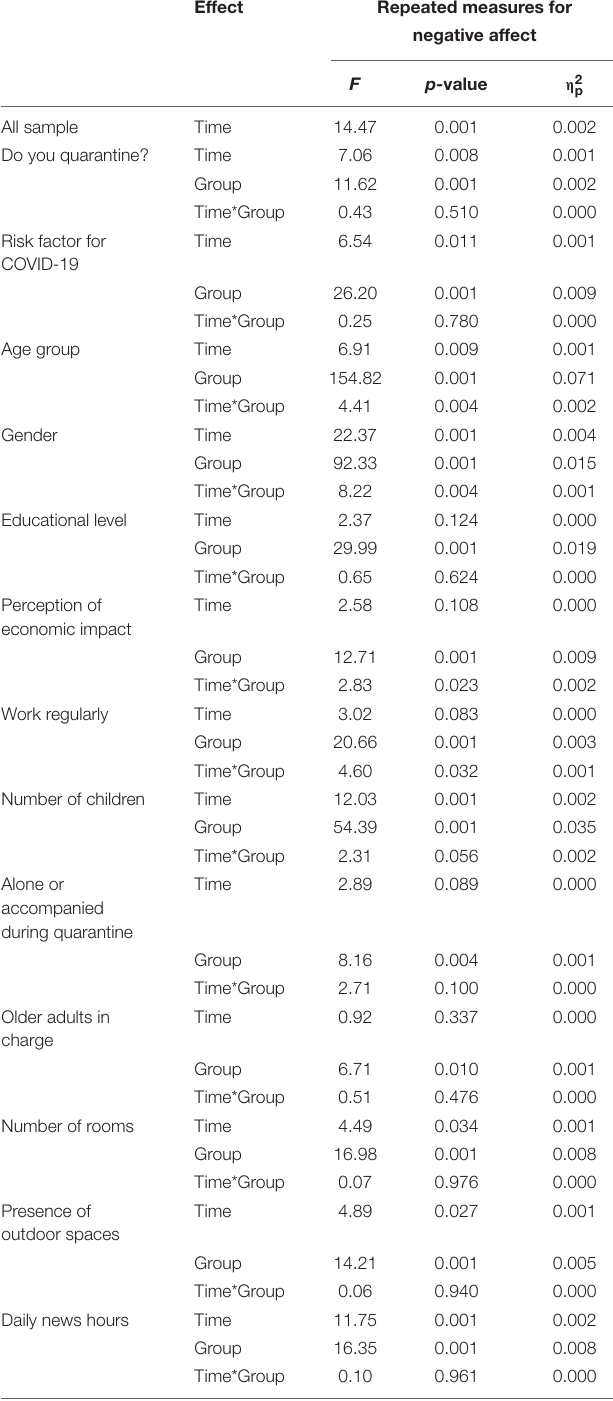
TABLE 9 | Results of repeated measures ANOVA for positive affect. Effect Repeated measures